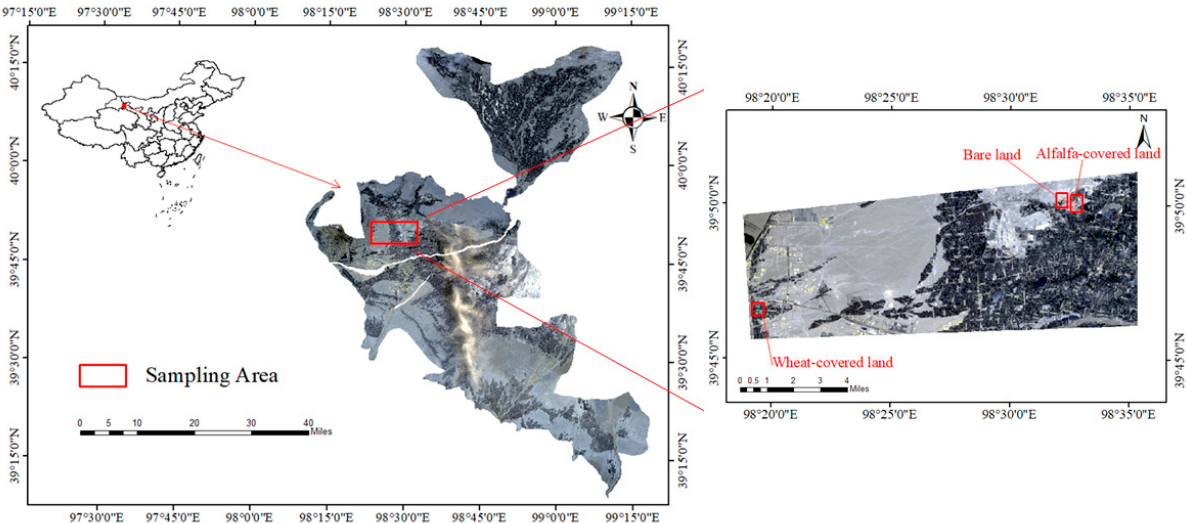
Figure 1. The geographical location of the study area.